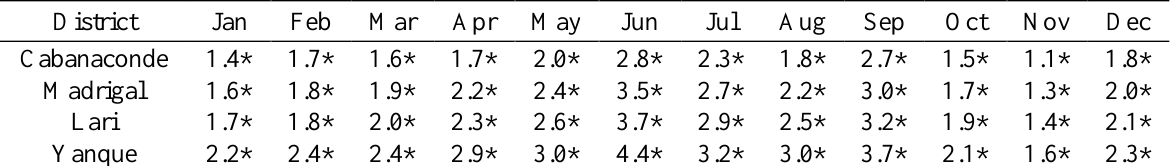
Table A 1 .4. Trends in Monthly Average Minimum Daily Air Temperature (°C) over the Period of 1988 to 2017 for the Different Districts District Dec Cabanaconde